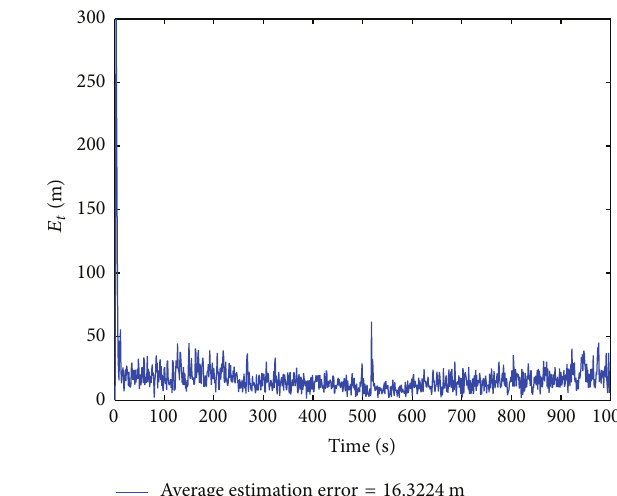
Figure 14: Estimation error of PSO based adaptive 𝛼 - 𝛽 - 𝛾 filter.